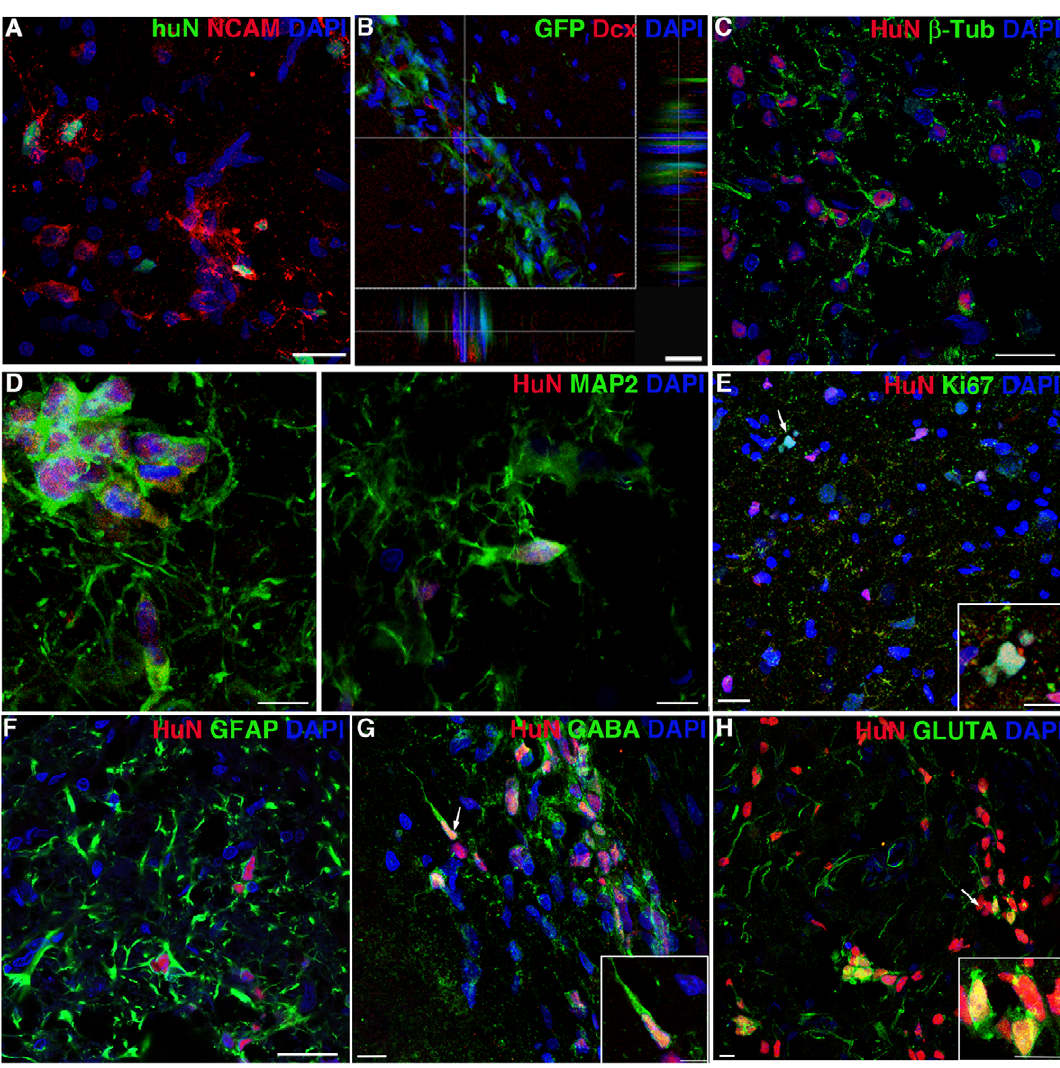
Figure 3. Differentiation of transplanted IhNSC-Ps in vivo. (A–F) IhNSC-Ps at 3 months post transplantation differentiate into both NCAM + HuN + (A, cc) and Dcx + /GFP + (B, dentate gyrus) neuronal progenitors and b -Tub + HuN + (C) and MAP2 + HuN + (D) mature neurons in the cortex. (E) Sporadic proliferating cells (Ki67 + HuN + , arrow and inset magnification). (F) GFAP + HuN + astroglial cells in the cortex. (G–H) IhNSC-Ps at 1 month from transplantation generate GABAergic (GABA + HuN + , arrow in G and inset magnification) and Glutamatergic neurons (GLUTA + HuN + , arrow in H and magnification). Scale bars: A, B, C, E, F: 20 m m, D, inset in E, G, H, inset in H: 10 m m, inset in G: 5 m m.